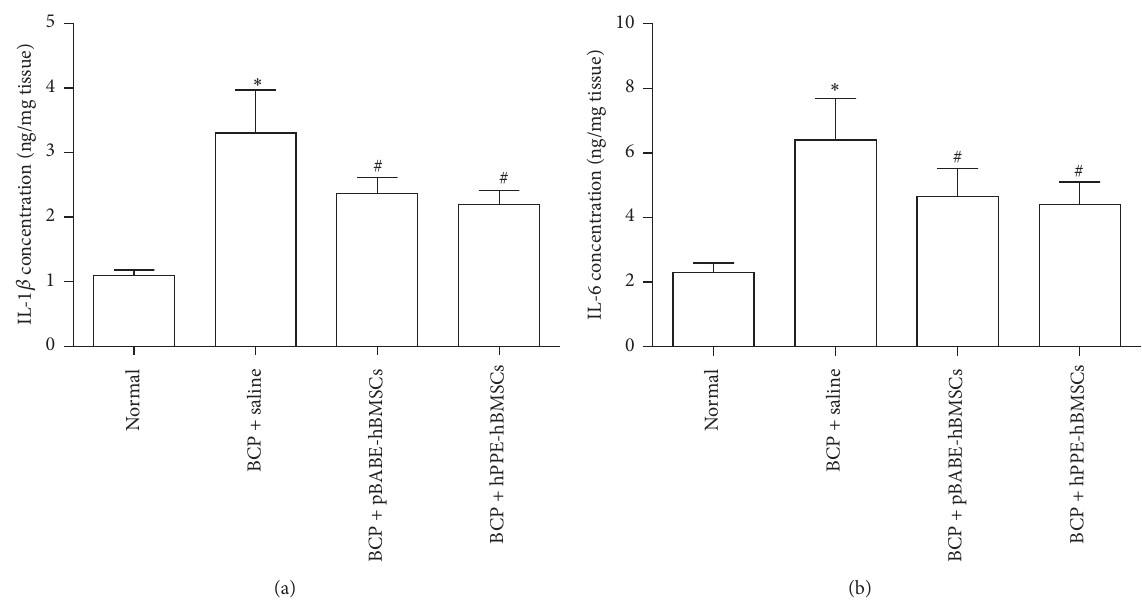
Figure6:EffectsofhPPE-hBMSCsonproinflammatorycytokinelevelsinthespinalcordsofratswithbonecancerpain(BCP)werecompared by enzyme-linked immunosorbent assay (ELISA). After treatment with cell transplantation for 3 d following BCP operation, the spinal cords were homogenized and the IL-1 𝛽 (a) and IL-6 (b) levels were measured. Normal, the normal group; BCP + saline, the BCP group; BCP + pBABE-hBMSCs, the BCP + pBABE-hBMSC group; BCP + hPPE-hBMSCs, the BCP + hPPE-hBMSC group. Data were expressed as the mean ± SEM. 𝑛 = 6 . Statistical analysis was performed by one-way analysis of variance followed by the least-significant difference or Dunnett T3 test. ∗ 𝑃 < 0.01 versus the normal group; # 𝑃 < 0.05 versus the BCP + saline group. hPPE, human proenkephalin; pBABE, a retroviral vector; hBMSCs, human bone marrow stem